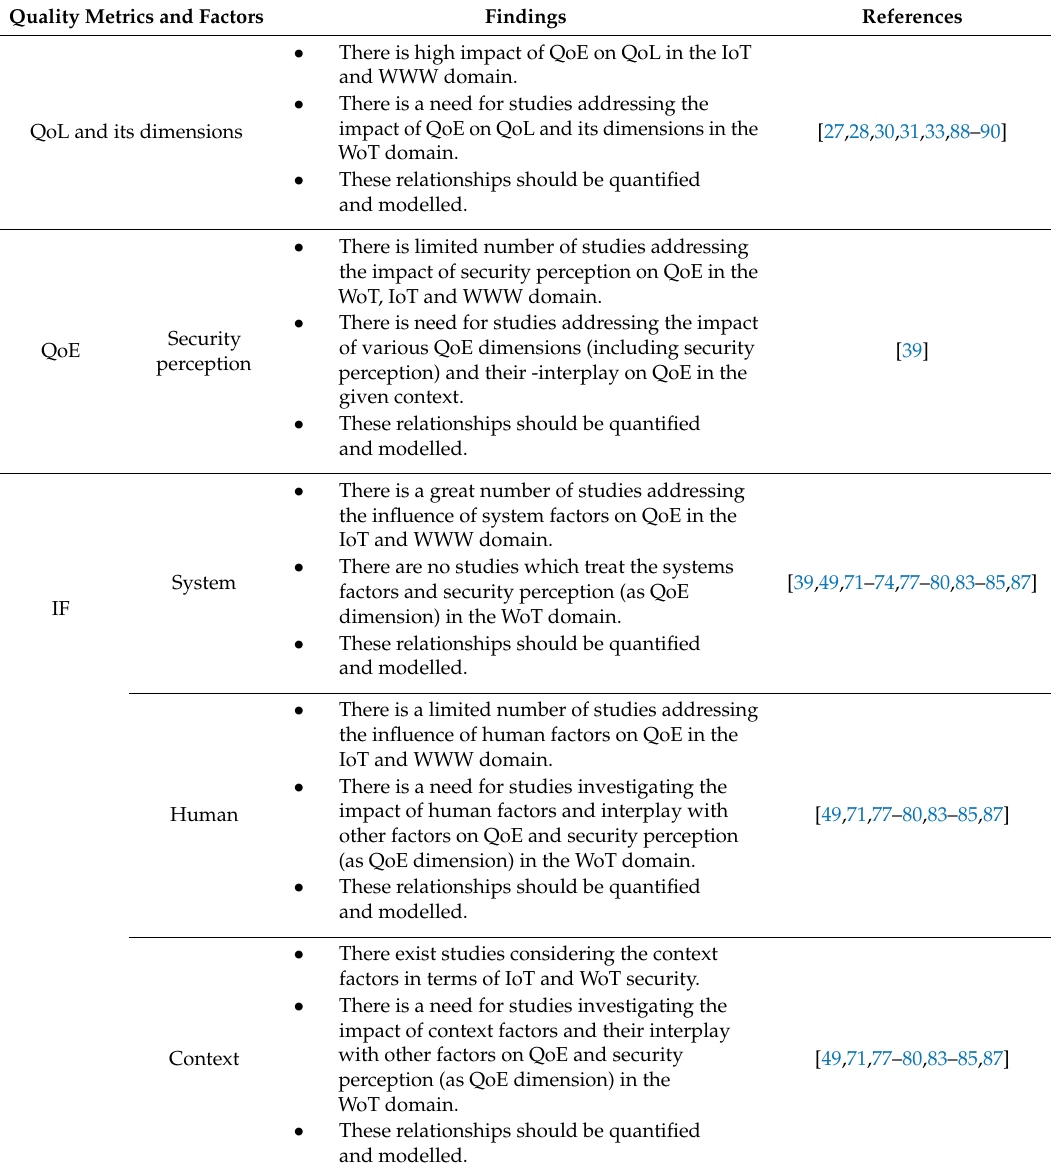
Table 1. Summary of results and discussion on dependencies between QoL, QoE, and security perception, as well as influence factors a ff ecting them in WoT, IoT, and WWW context. Quality Metrics and